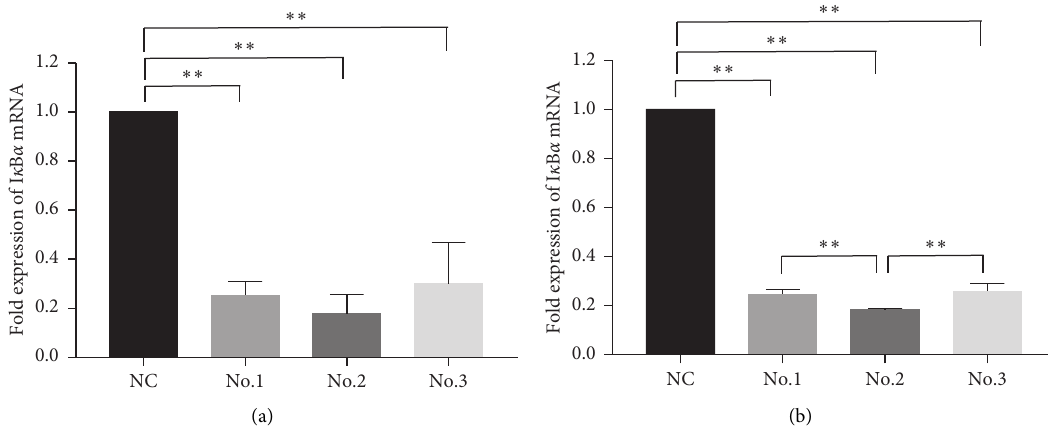
Figure 3: Real-time PCR for detection of I κ B α mRNA expression after NC-siRNA and three pairs of I κ B α -siRNA were transfected into CM cells and TM cells, respectively, at 10nM. (a) The three pairs of I κ B α -siRNA could all inhibit the I κ B α gene expression, and the inhibitory rate of No.2 was higher than that of the other two pairs in CM cells. (b) The three pairs of I κ B α -siRNA could all inhibit the I κ B α gene expression, and the inhibitory rate of No.2 was higher than that of the other two pairs in TM cells. ∗ P < 0 . 05; ∗∗ P < 0 . 01.